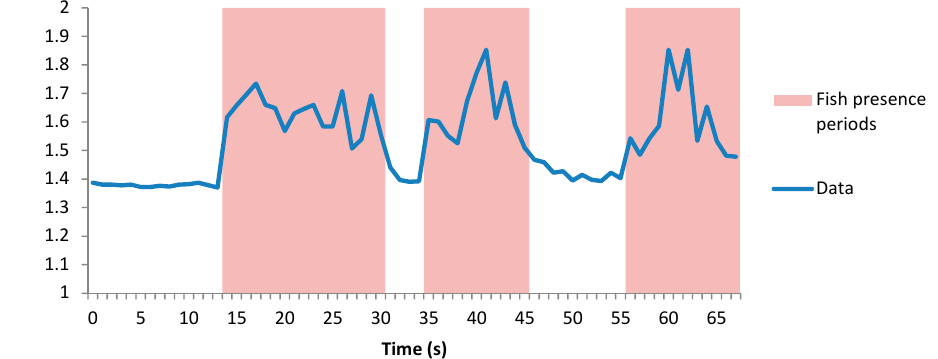
Figure 17. Data gathered by the fish presence sensor.